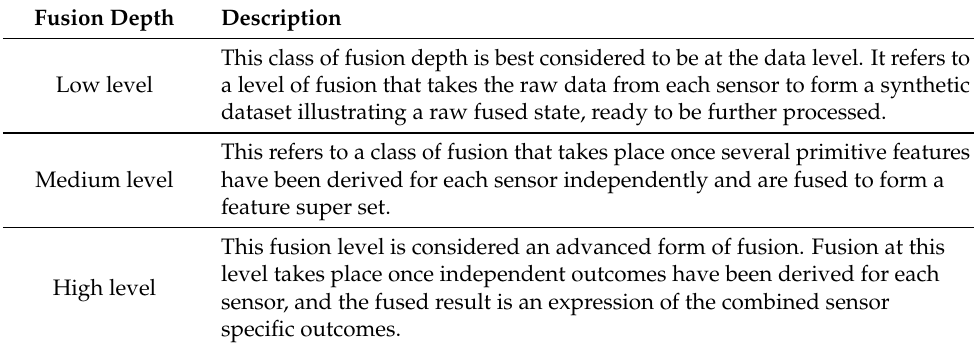
Table 2. Types of mmWave radar and camera-fusion